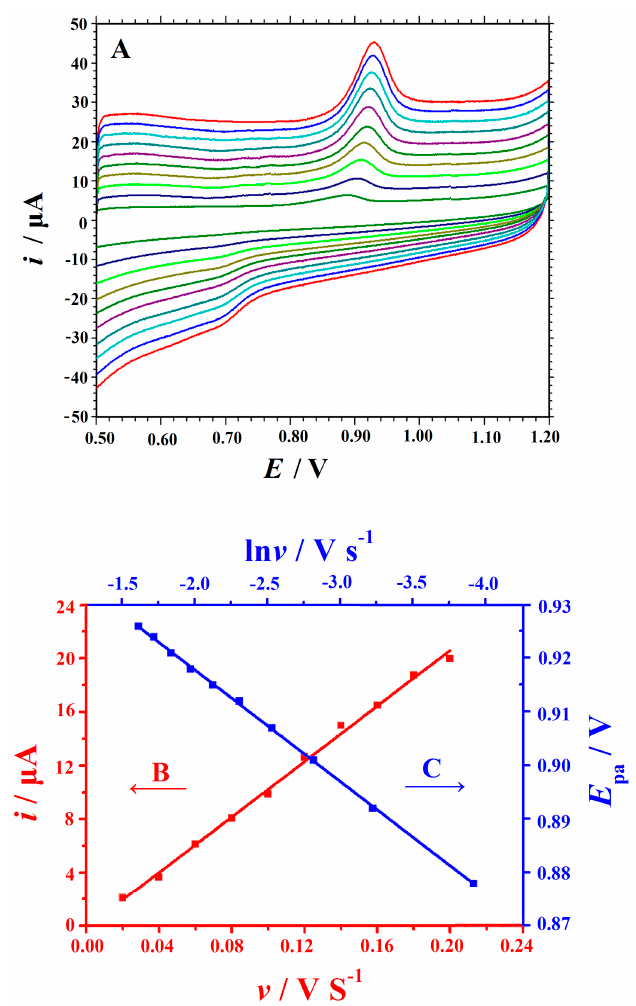
Figure 5. ( A ) CV curves of 10 µ M vanillin at Cu 2 O NPs-ERGO/GCE with different scan rates in 0.1 M H 2 SO 4 . From inner to outer: 0.02, 0.04, 0.06, 0.08, 0.10, 0.12, 0.14, 0.16, 0.18, and 0.20 V s − 1 , respectively; the plots for ( B ) the dependence of peak currents (i pa ) on the scan rates (v) and ( C ) the relationship between peak potentials (E pa ) and Neperian logarithms of scan rates (ln v).